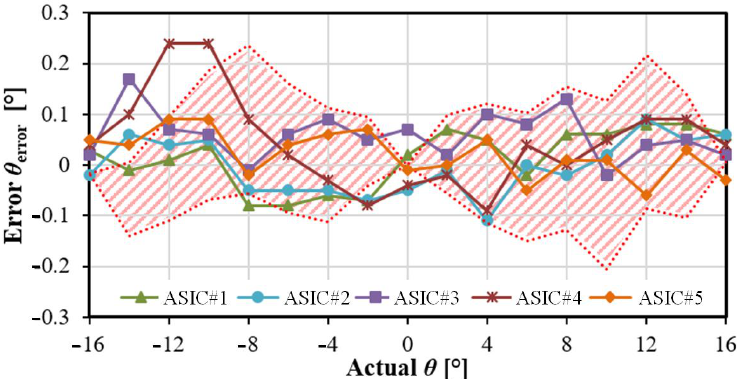
Figure 8. Measured accuracies from 5 ASICs, compared to MC analysis (hatched area); the supply is nominal, i.e., 1.8 V.